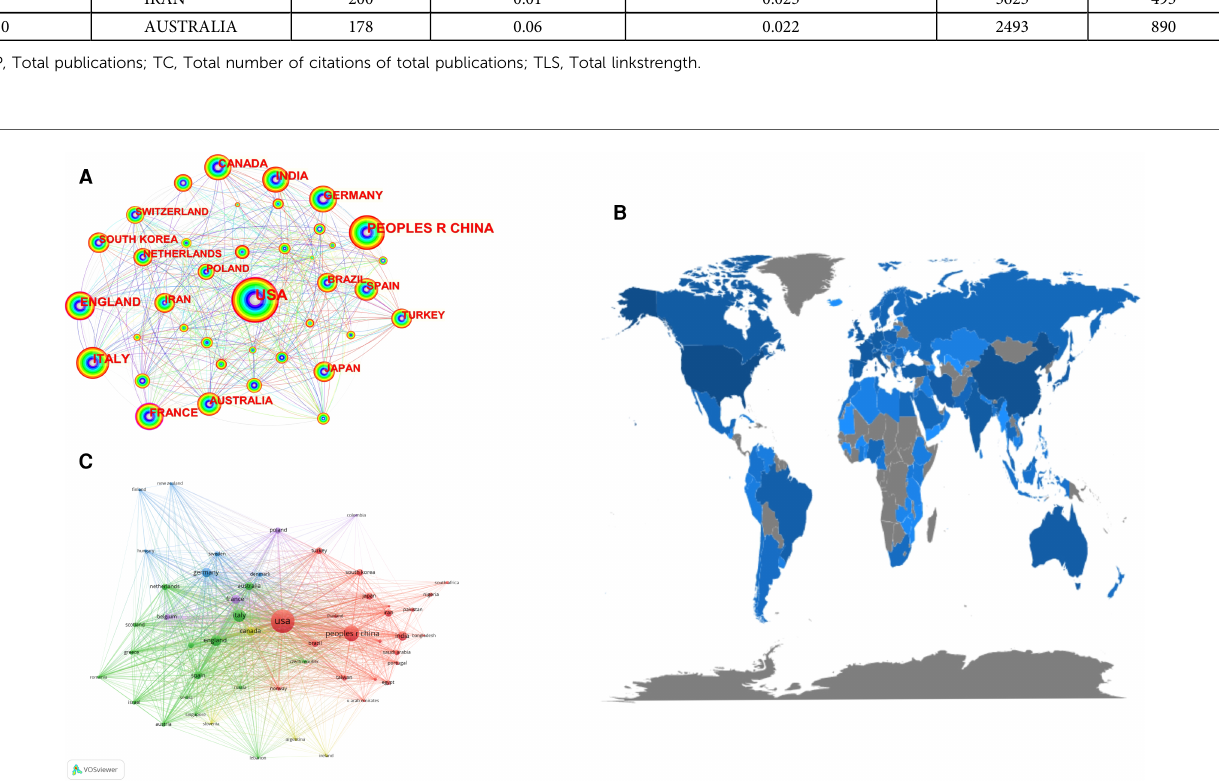
Table 3 . Moslehi, Javid ( n = 2,230) and Ky, Bonnie ( n = 1,375)